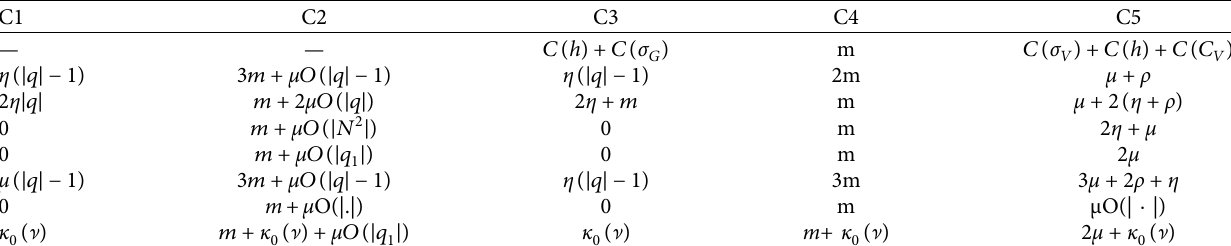
Table 1: Contrast in terms of the ranked cost.